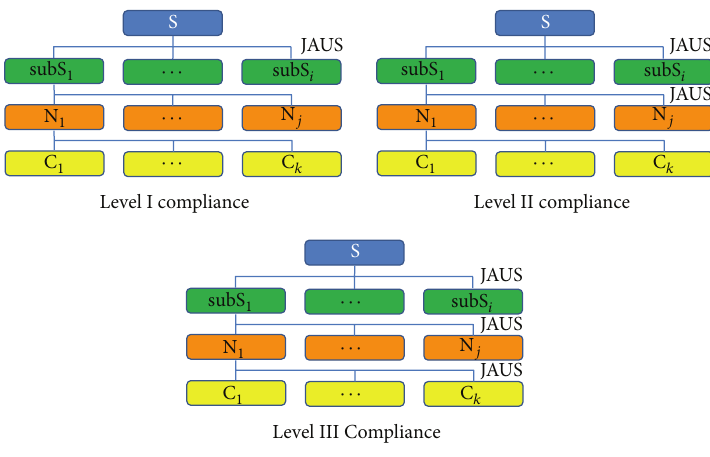
Figure 5: JAUS hierarchy and Compliance Level. S: system, subs: subsystem, N: node, C: